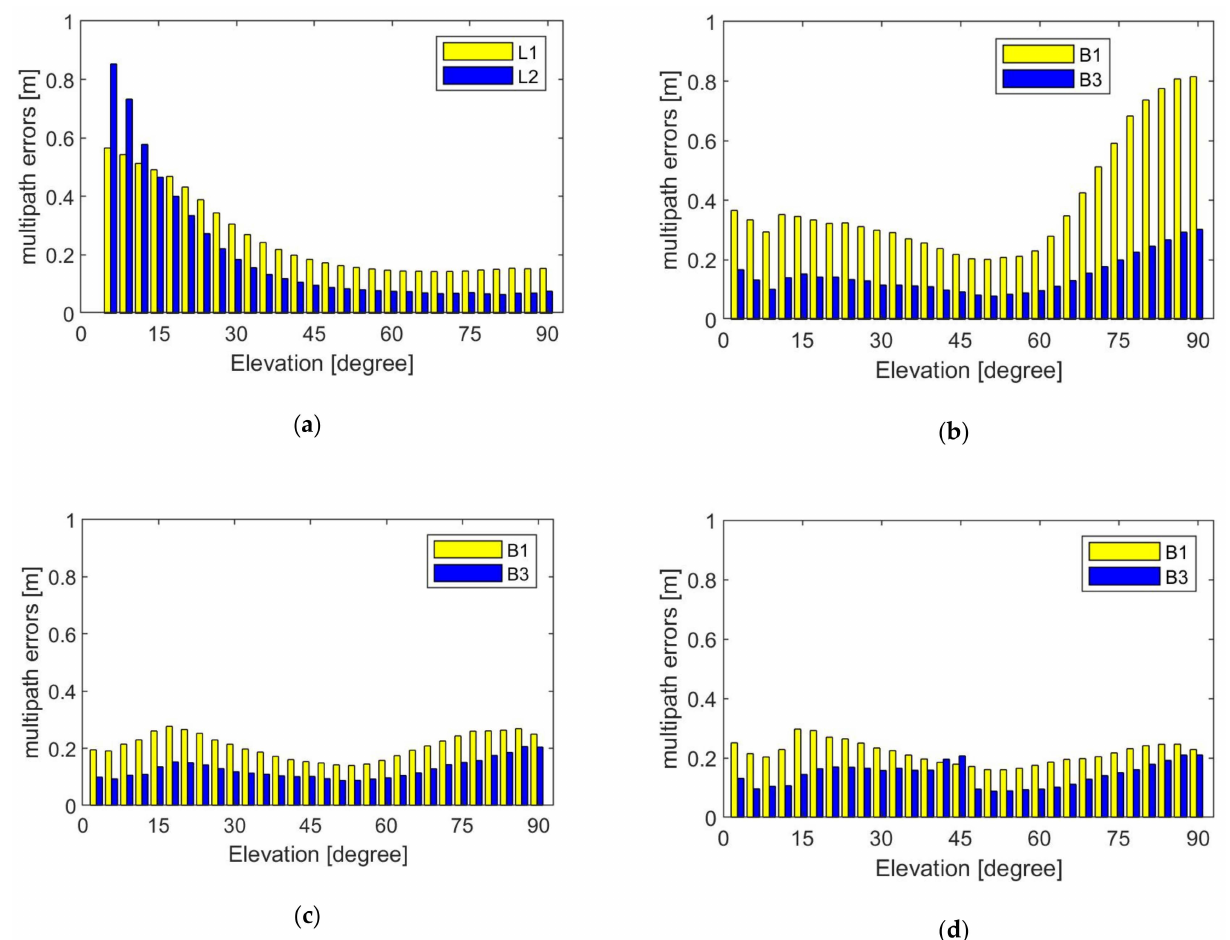
Figure 3. Variation in code multipath error with elevation angle for different satellites: ( a ) GPS satellites, ( b ) BDS2 Medium Earth Orbit satellites (MEO) satellites, ( c ) BDS2 Inclined Geosynchro-nous Orbit satellites (IGSO) satellites, and ( d ) BDS2 Geostationary Earth Orbit (GEO) satellites.